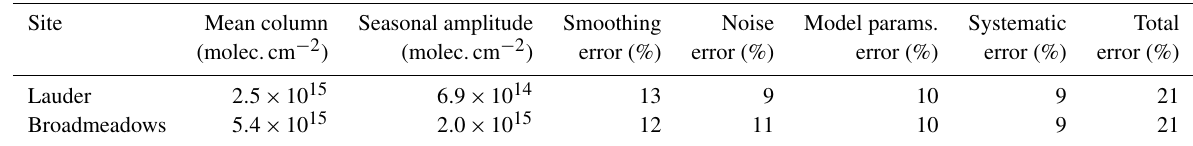
Table 1. Summary of MAX-DOAS formaldehyde results and the error budget from Lauder and Broadmeadows. Site Mean column Seasonal amplitude Smoothing Noise Model params. Systematic Total (molec.cm − 2 ) (molec.cm − 2 ) error (%) error (%) error (%) error (%) error (%) Lauder Broadmeadows 5 . 4 × 10